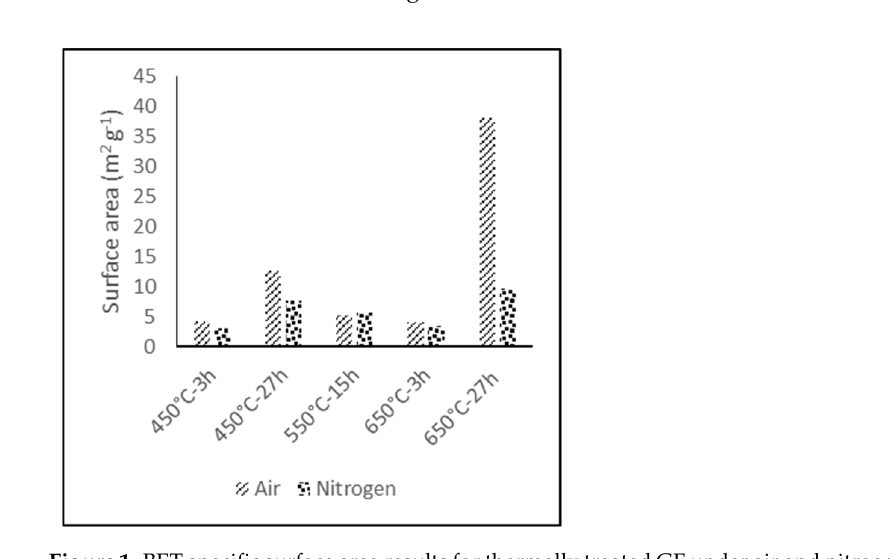
Figure 1. BET specific surface area results for thermally treated GF under air and nitrogen atmosphere.